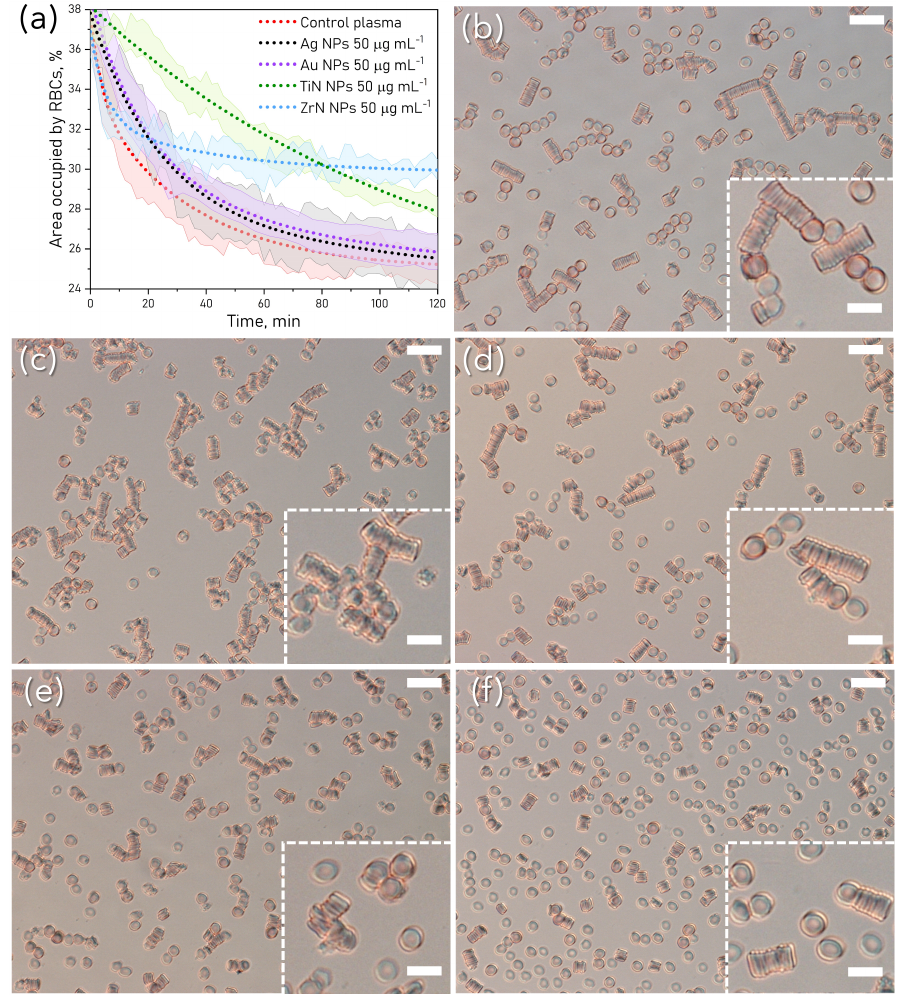
Figure 3. ( a ) Kinetics of RBC aggregation as the change of area occupied by RBC. Dotted lines are average data fitted by one-exponential decay with shaded areas representing the standard deviation. ( b – f ) Optical microscopy images of RBC incubated with NP with enlarged insets of aggregates after 2 h in autologous blood plasma: ( b ) control, ( c ) Ag NP, ( d ) Au NP, ( e ) TiN NP, and ( f ) ZrN NP at concentration 50 µ gmL − 1 . Scale: 20 µ m (main images), 10 µ m (insets). Relative RBC deformation was defined by applying viscous blood plasma flow (100 µ m/s) against a trapped RBC for discocytes and for EII (Figure 4d,e).